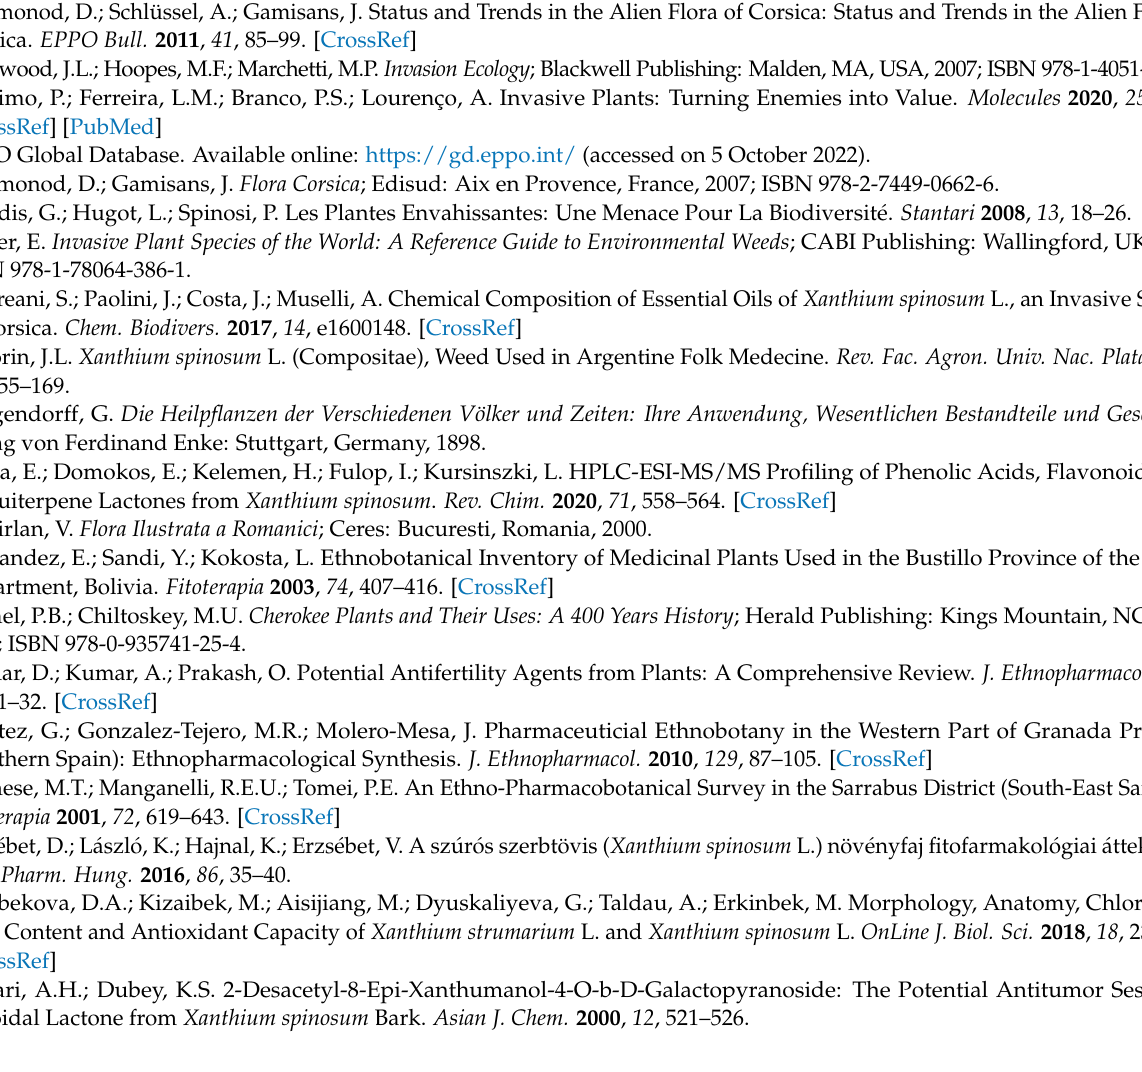
Figure S13: 13 C NMR Spectrum of 65 ; Figure S14: 1 H NMR Spectrum of 65 ; Figure S15: 13 C NMR Spectrum of 67 ; Figure S16: 1 H NMR Spectrum of 67 ; Figure S17: HMBC Spectrum of 67 ; Figure S18: HSQC Spectrum of 67 ; Figure S19: COSY Spectrum of 67 ; Figure S20: NOESY Spectrum of 67